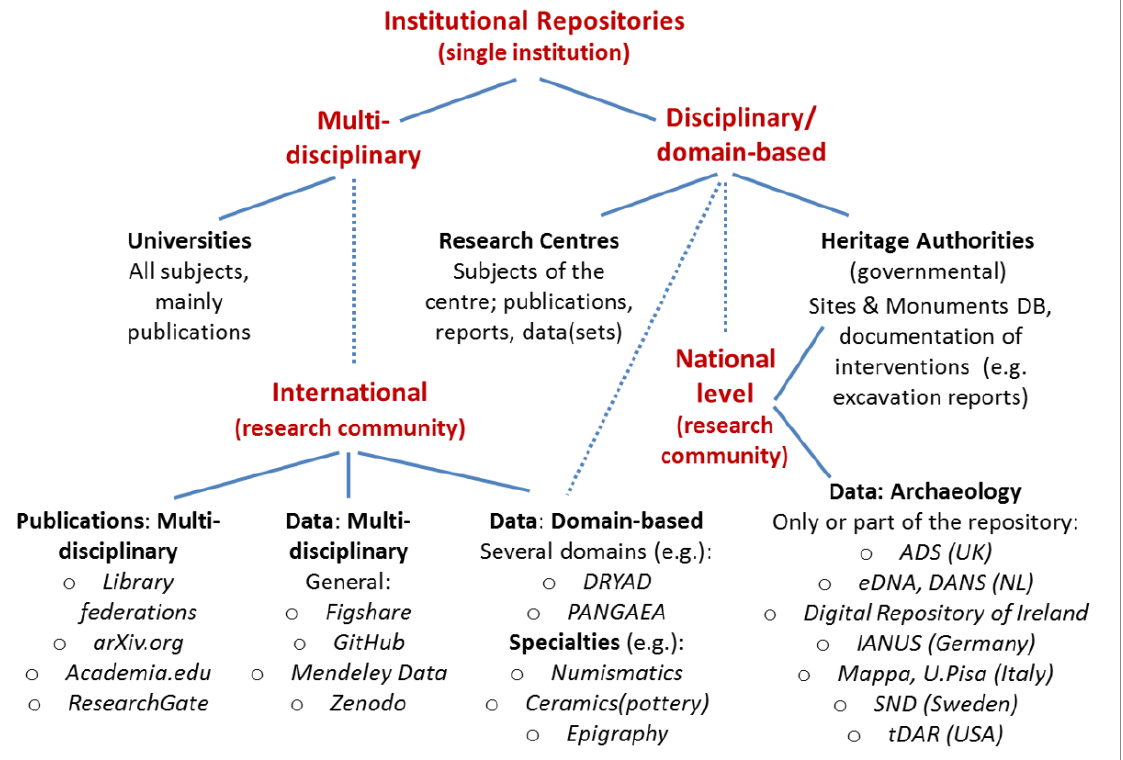
Figure 6 : Categorisation of types of repositories (source: ARIADNEplus / Salzburg Research,